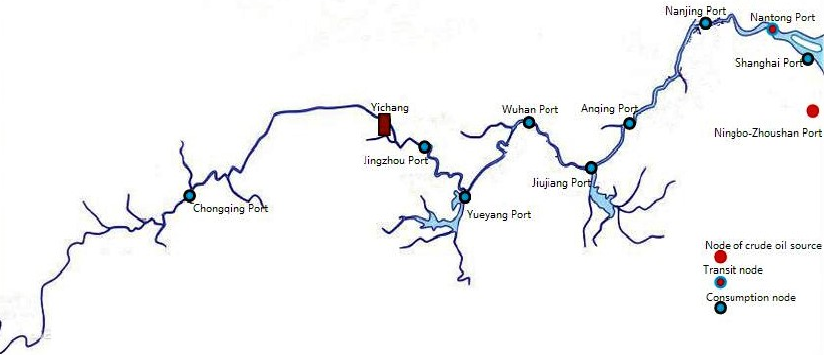
Figure 1. Crude oil transportation nodes in the Yangtze River Basin.